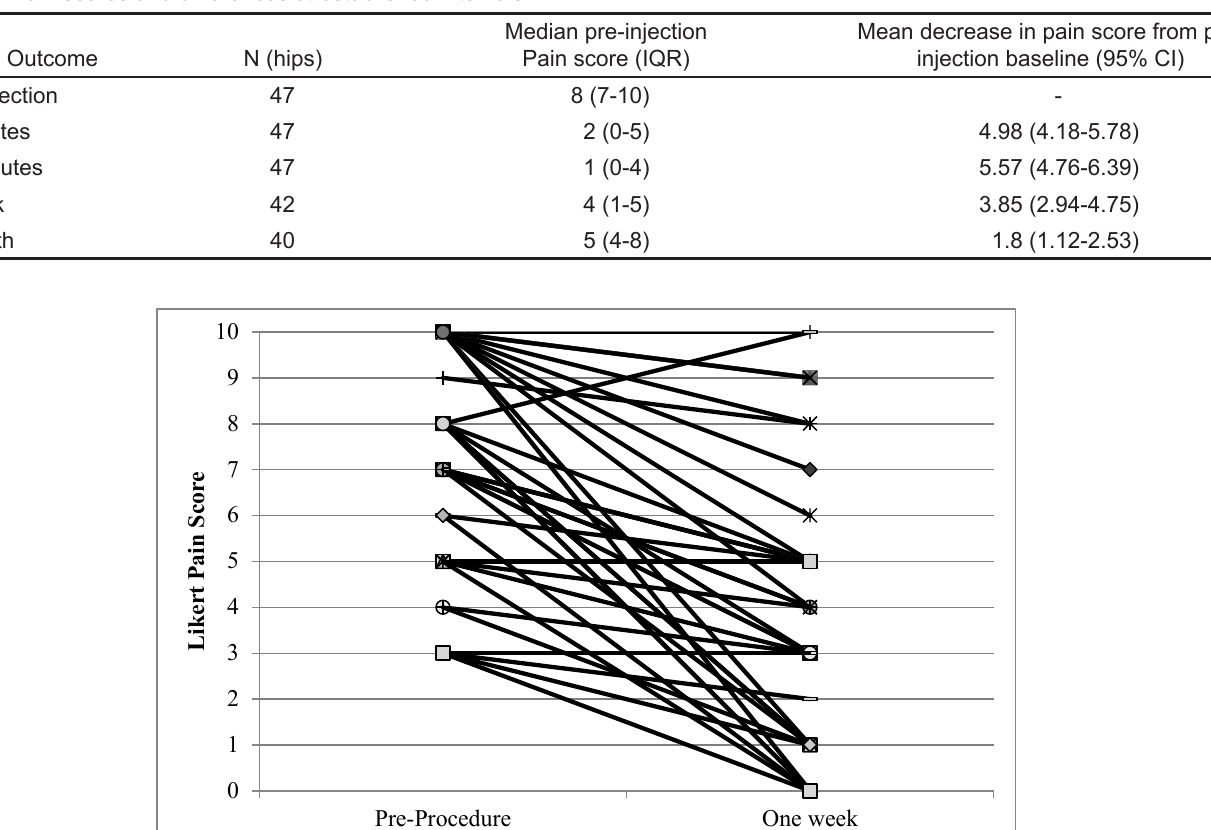
Table 2. Pain scores and differences at established intervals.